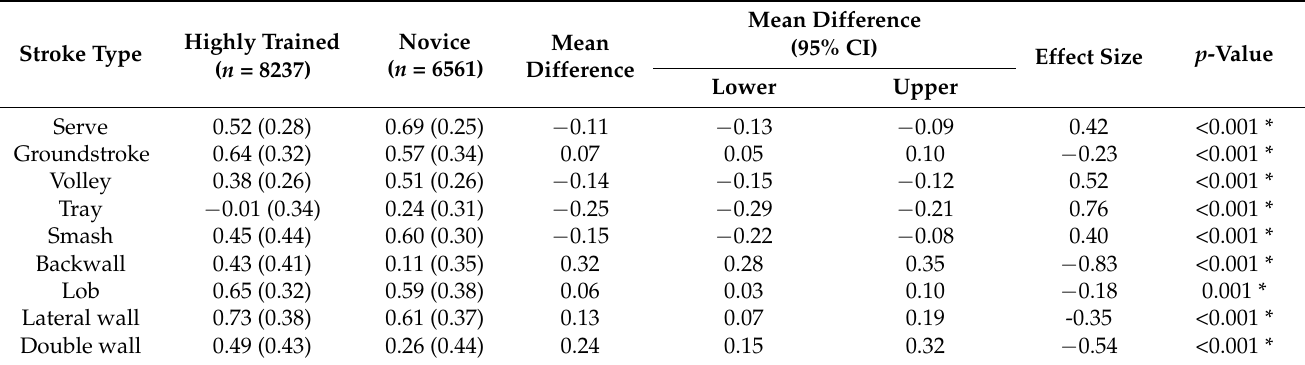
Table 1. Mean differences in the ball impact position (m) between highly trained and novice padel players in different stroke types.